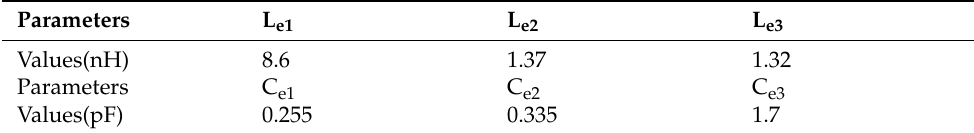
Table 1. The obtained values of capacitances and inductances.